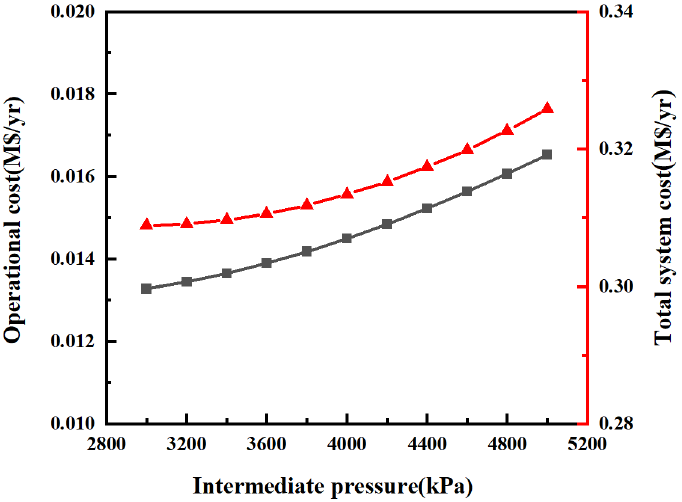
Figure 11. Operating costs and total costs of the components of a coupled system varied with the intermediate pressures.